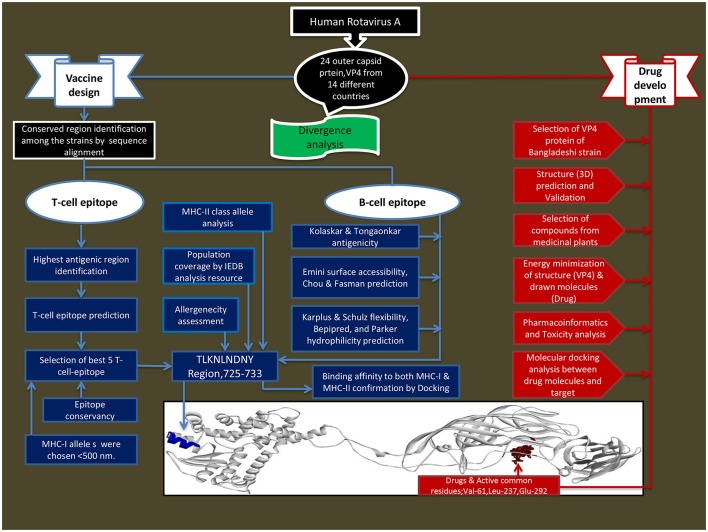
Schematic presentation of vaccine and drug designed against human rotavirus.